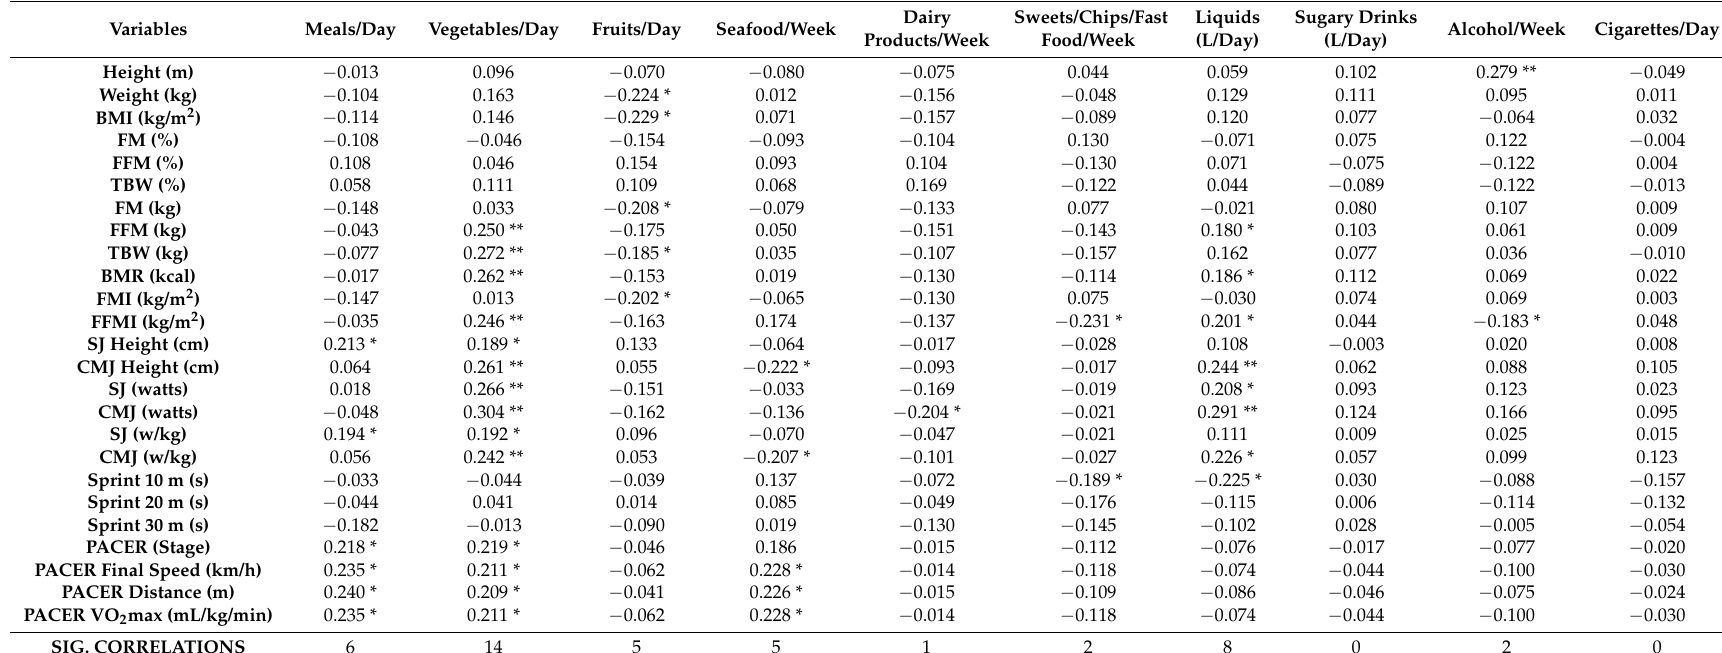
Table 6. Correlations nutrition—body composition and physical